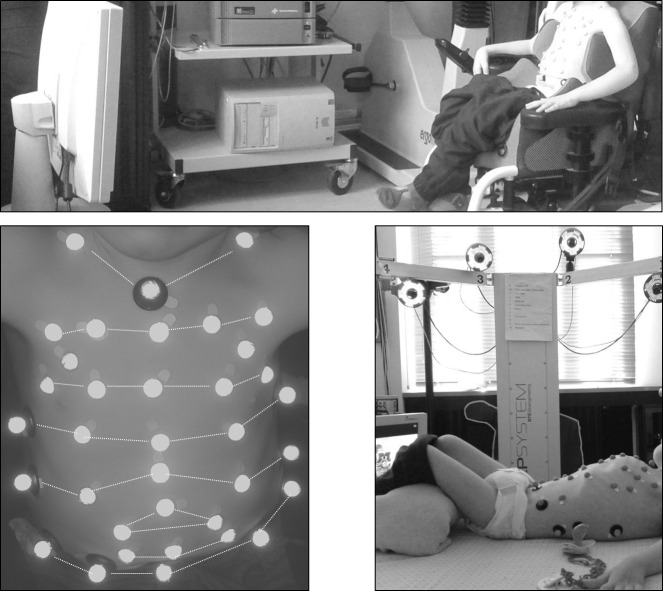
Experimental set-up for the analysis of chest wall volumes via opto-electronic plethysmography of a SMA child in seated (top) and supine (bottom right) positions while watching a cartoon.SMA3 and HC could sit without support and therefore 89 and 52 markers were respectively used in seated and supine position[44,45,48,50]. SMA2 children were all wheelchair bound and in both postures a new model was used with five horizontal rows of five markers, three rows of three markers with two additional markers making a total of 36 (bottom left). SMA1 were analyzed only in supine position, using the 36 model as well.